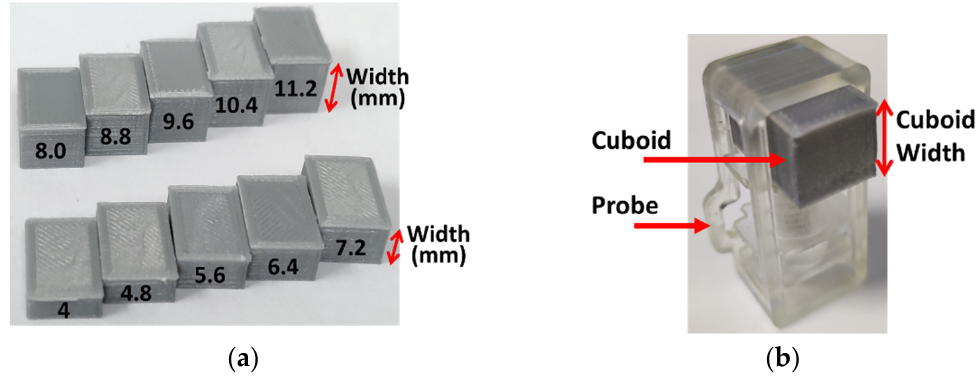
Figure 8. Probes calibration using cuboids: ( a ) Different sizes of 3D-printed cuboids (4 – 11.2 mm); ( b ) How the cuboids are placed inside the probes for calibration.